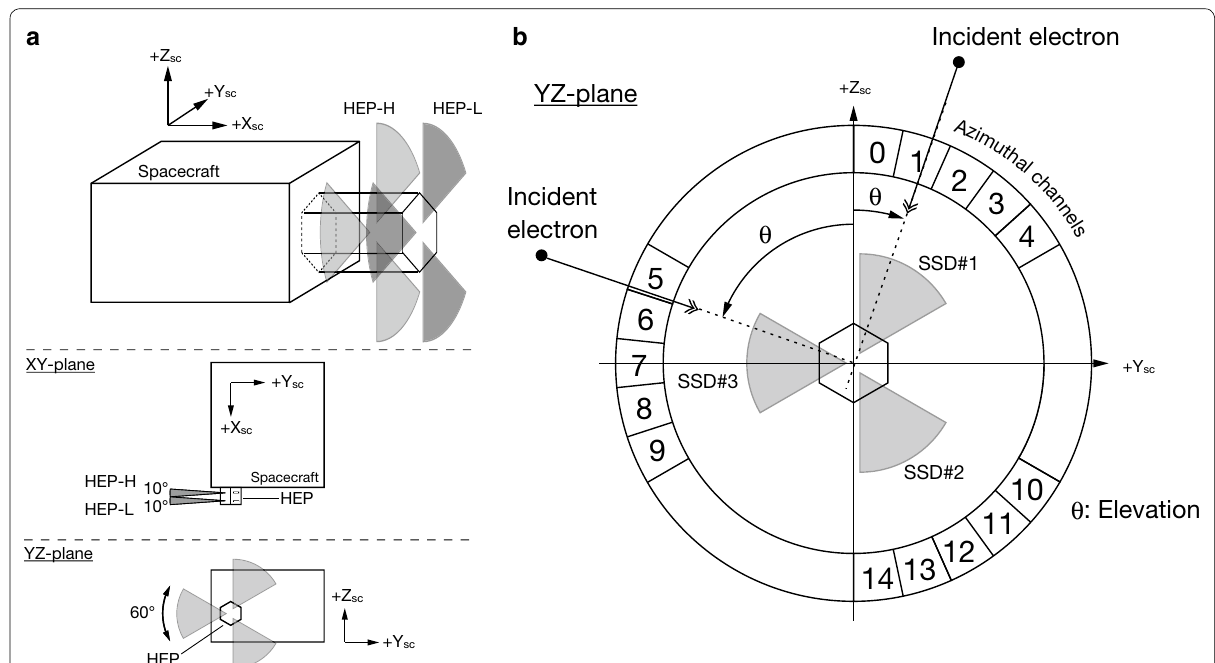
Fig. 2 a HEP mounted on ERG satellite and b instruments’ field of view. The HEP instrument located on the (not to scale). The satellite rotates around the Z sc -axis. Fields of view of six detector modules are shown as gray areas; each module has a 60° (Elevation) 10° (Azimuth) field of view. b Fields of view of three detector modules are shown as gray areas in the YZ -plane. Each module has a field × of view of 60° and is divided into five channels such that each channel covered 12°. Elevation angle ( θ ) is the angle between incident